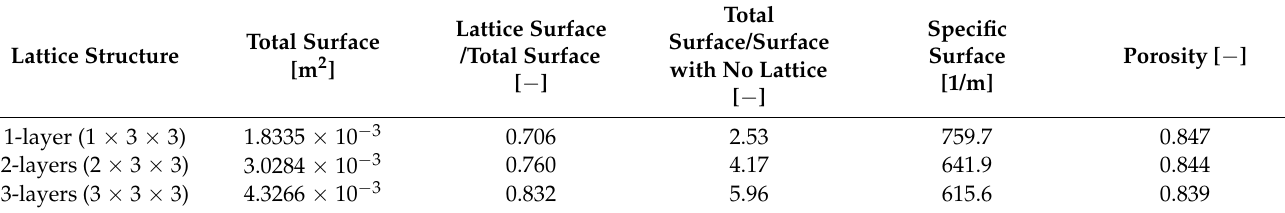
Table 3. Geometrical parameter of the lattice structures. The total surface is the sum of the lattice and the flat channel surfaces connected to the lattice. The specific surface is computed as the ratio of the total surface to the volume of the box (fluid + solid) in which the lattice is